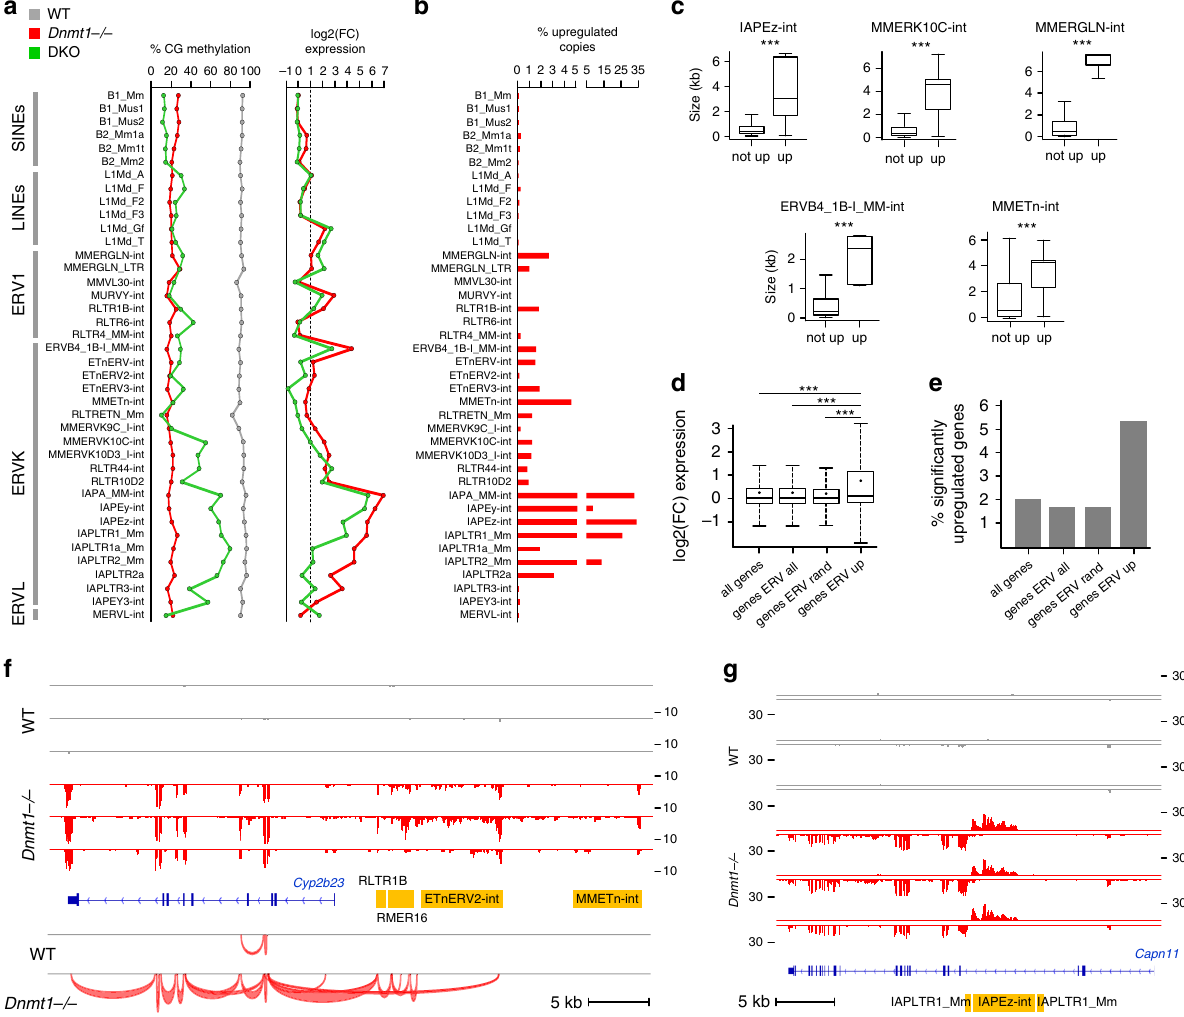
Fig. 5 Dnmt mutant embryos show widespread transposon upregulation. a DNA methylation measured by WGBS and fold change of expression of SINE, LINE, ERV1, ERVK, and EVRL retrotransposons in Dnmt1 − / − and DKO embryos. Methylation and expression was calculated on RepeatMasker annotations. b Percentage of signi fi cantly upregulated copies within each retrotransposon family in Dnmt1 − / − embryos. c Boxplots comparing the size of transposon copies upregulated in Dnmt1 − / − embryos (up) or not upregulated (not up) for several ERV families. *** p < 0.001 (Wilcoxon test). In the boxplots the line indicates the median, the box limits indicate the upper and lower quartiles and the whiskers extend to 1.5 IQR from the quartiles. IAPEz-int: n = 4835 (not up), n = 2484 (up), p = 0; MMERVK10C-int: n = 3193 (not up), n = 37 (up), p = 1.53e − 14; MMERGLN-int: n = 834 (not up), n = 22 (up), p = 2.15e − 12; ERVB4_1B-I_MM-int: n = 1347 (not up), n = 21 (up), p = 8.03e − 12; MMETn-int: n = 936 (not up), n = 44 (up), p = 3.97e − 14. d Fold change of expression of genes located close to upregulated ERVs (genes ERV up, n = 715) compared with all genes, genes located close to all ERVs (genes ERV all) and a random selection of 715 genes located close to ERVs (genes ERV rand). In the boxplots the line indicates the median, the dot indicates the mean, the box limits indicate the upper and lower quartiles and the whiskers extend to 1.5 IQR from the quartiles. *** p < 0.001 (Wilcoxon test). e Percentage of signi fi cantly upregulated genes in Dnmt1 − / − embryos for genes located close to upregulated ERVs and control genes. f Cyp2b23 expression is induced by an upstream cluster of ERVs, which initiates a long RNA that splices into the exon 2. The fi gure shows RNA-seq tracks in WT and Dnmt1 − / − embryos, along with splice junctions in one replicate of WT and Dnmt1 − / − embryo. ERVs annotated by RepeatMasker are displayed in yellow. g RNA-seq tracks in WT and Dnmt1 − / − embryos illustrating that the derepression of an intragenic IAPEz element leads to internal initiation of the Capn11 gene on the opposite strand. The RNA- seq signals from the top (above the line) and bottom (below the line) strands are shown. IAPs annotated by RepeatMasker are displayed in